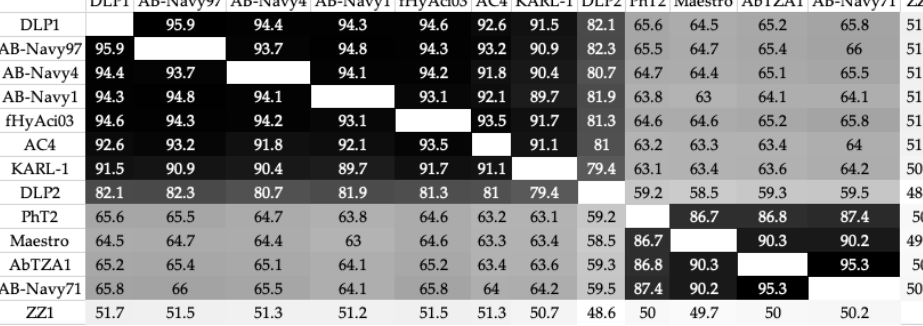
Viruses 2023 , 15 , x FOR PEER REVIEW 20 of 26